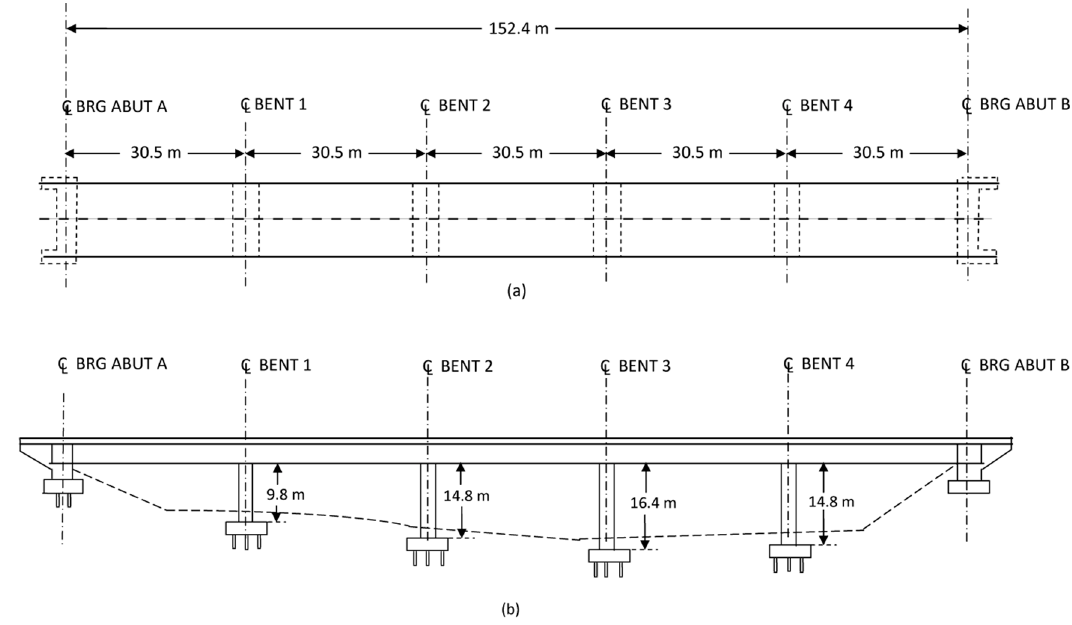
Figure 1. Bridge structure. ( a ) Plan and ( b ) Elevation (reproduced from Zhu et al. [27]).